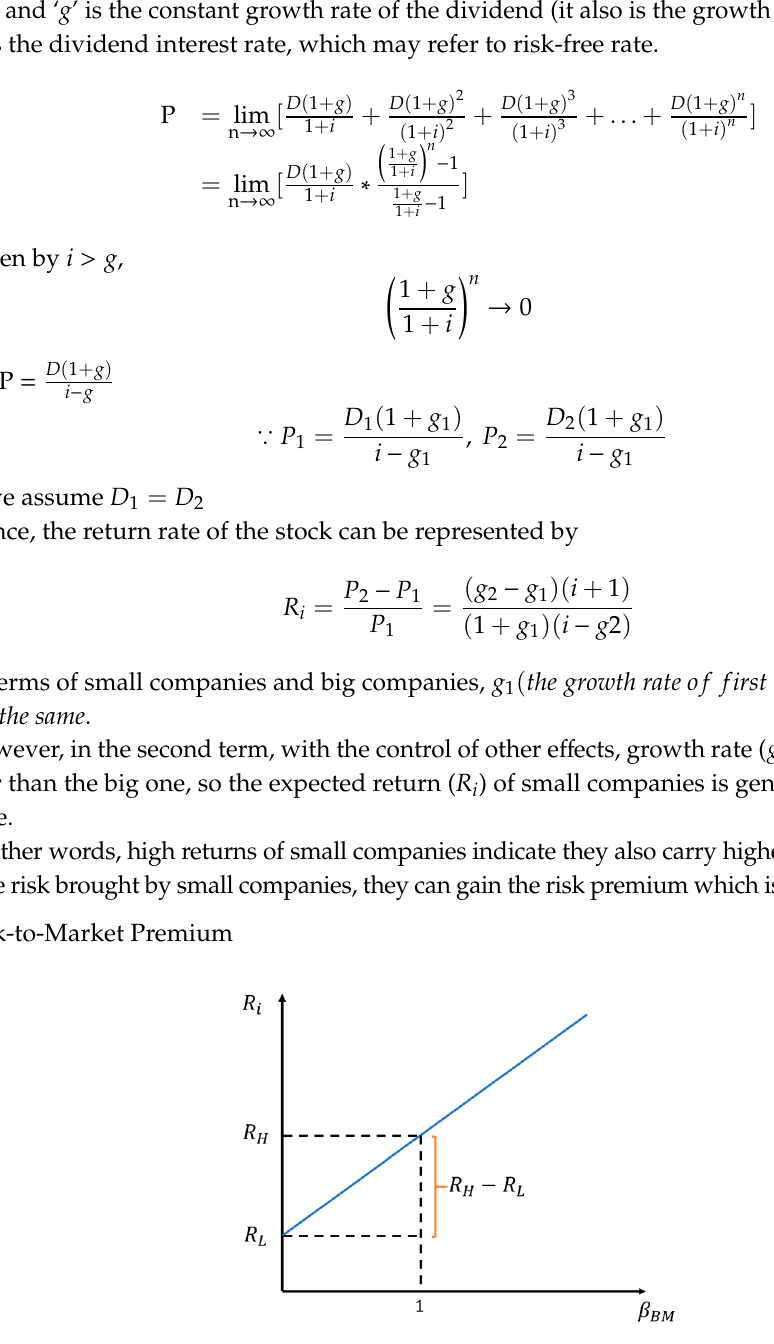
Figure A3. Positive relationship between expected return and book-to-market premium.